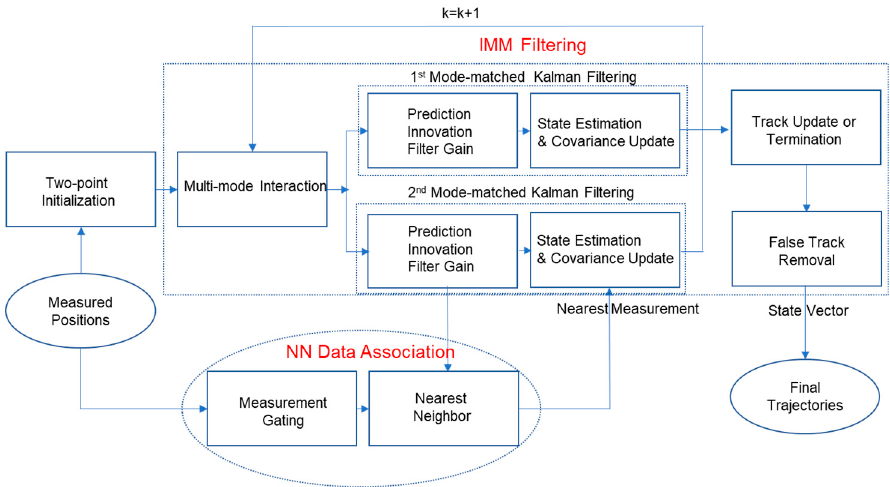
Figure 3. Block diagram of moving object tracking.